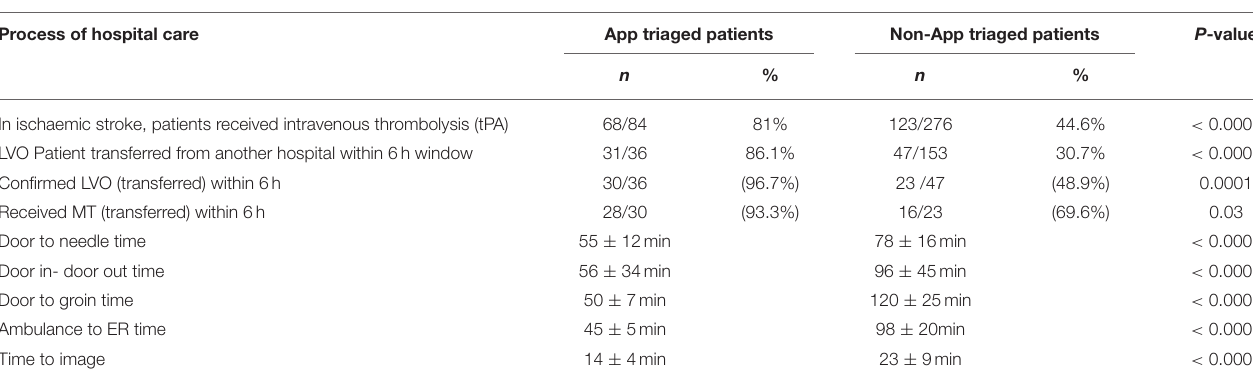
TABLE 3 | Type of reperfusion therapy and time metrics in treatment workflow. Process of hospital